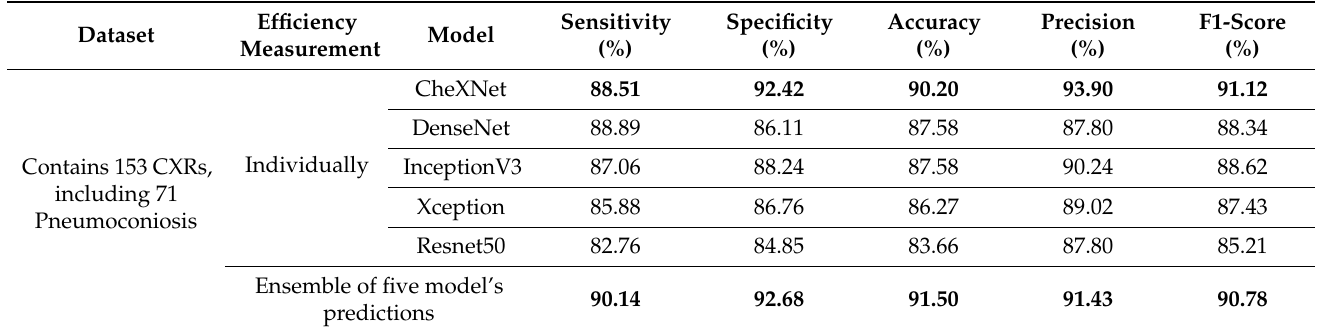
Table 13. The performance of the leave-one-out method with five DL models.